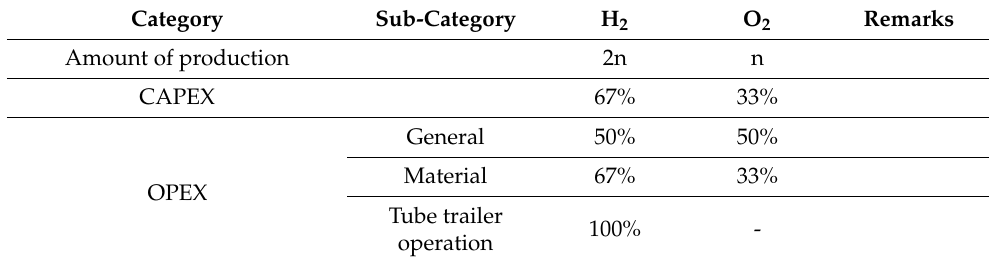
Table 43. Allocation of expenses with commercialized oxygen production